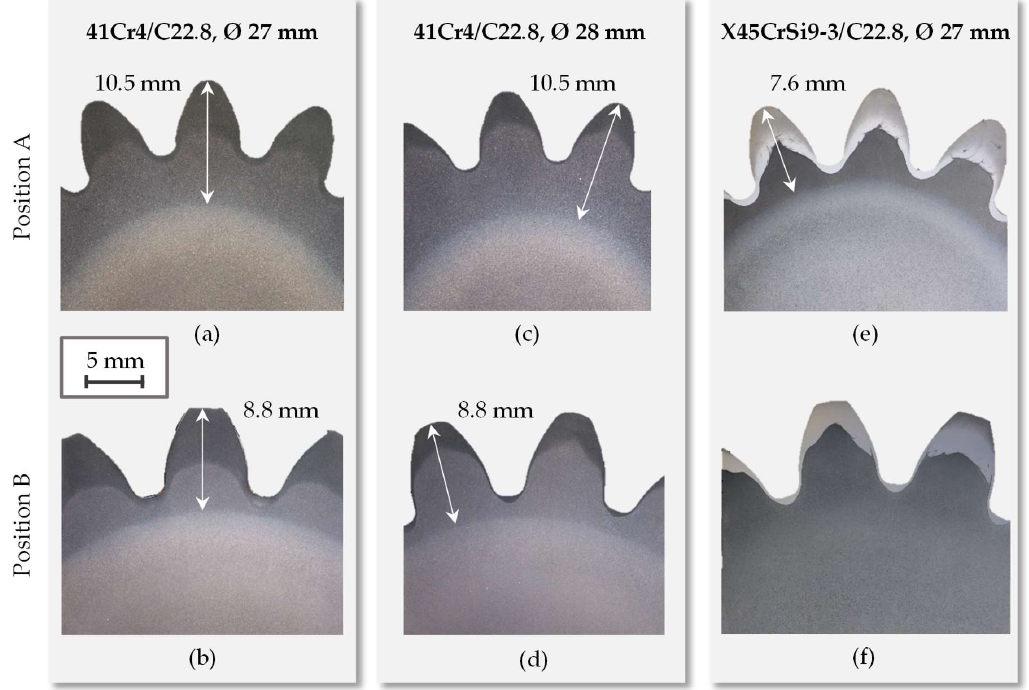
Figure 10. Heat-a ff ected zones after quenching and self-tempering in bevel gears of the material Figure 10. Heat-affected zones after quenching and self-tempering in bevel gears of the material combinations 41Cr4 / C22.8 ( a – d ) and X45CrSi9-3 / C22.8 ( e , f ) at position A ( a , c , e ) and B ( b , d , f combinations 41Cr4/C22.8 ( a – d ) and X45CrSi9-3/C22.8 ( e , f ) at position A ( a , c , e ) and B ( b , d , f ).